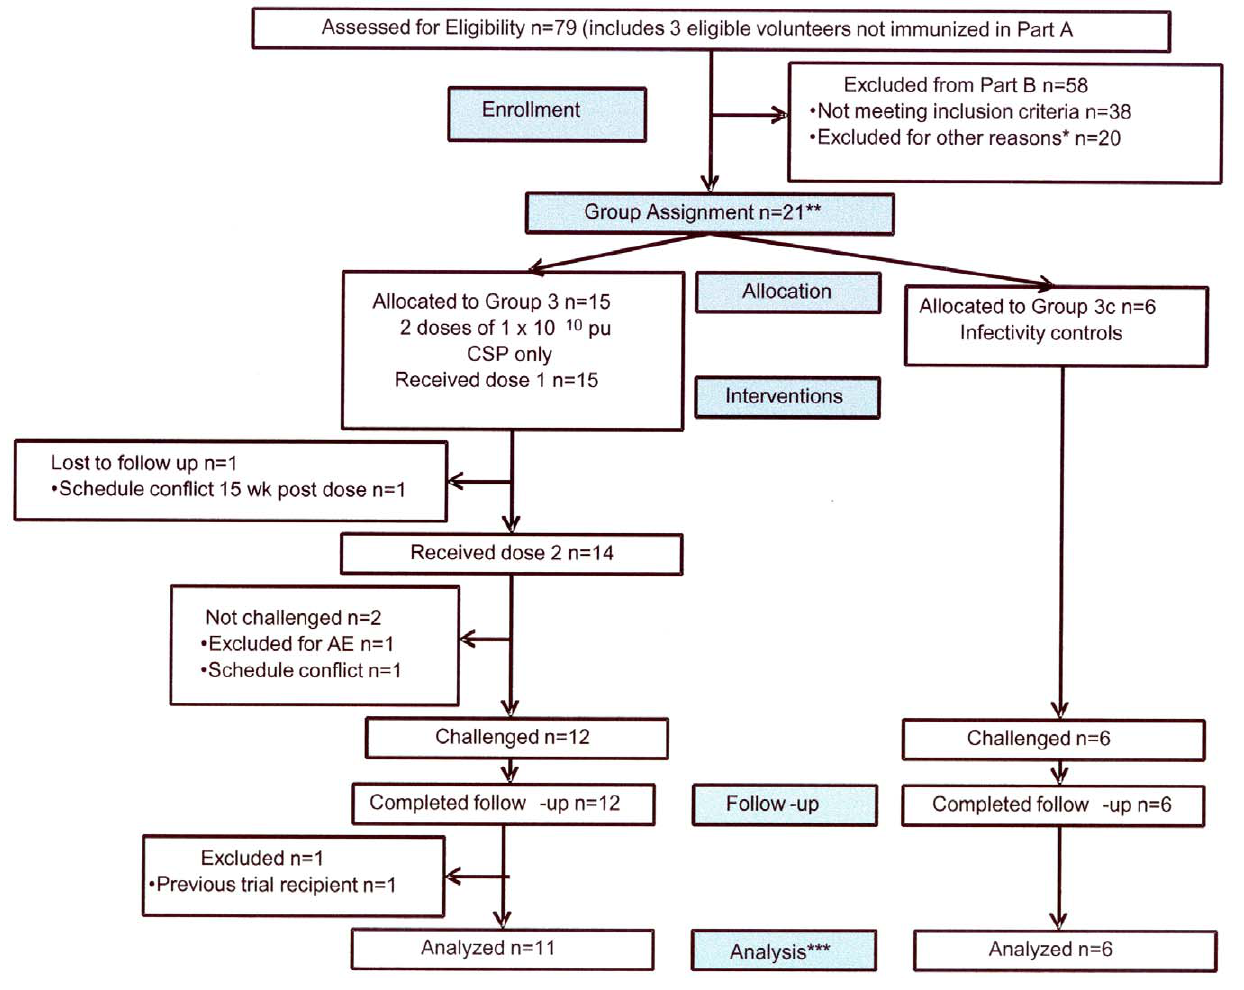
Figure 1. Flow diagram of volunteers (Group 3). * Reasons for exclusion: Moved out of area (3), deployed (2), lost to follow up (2), opted out (1), eligible but preferred waiting for follow-on study (12). ** The first 15 volunteers were allocated to the vaccine group and the final six volunteers to infectivity controls. *** 11 volunteers analyzed for immunogenicity and protection; 15 analyzed for safety of dose 1, 14 for safety of dose 2.